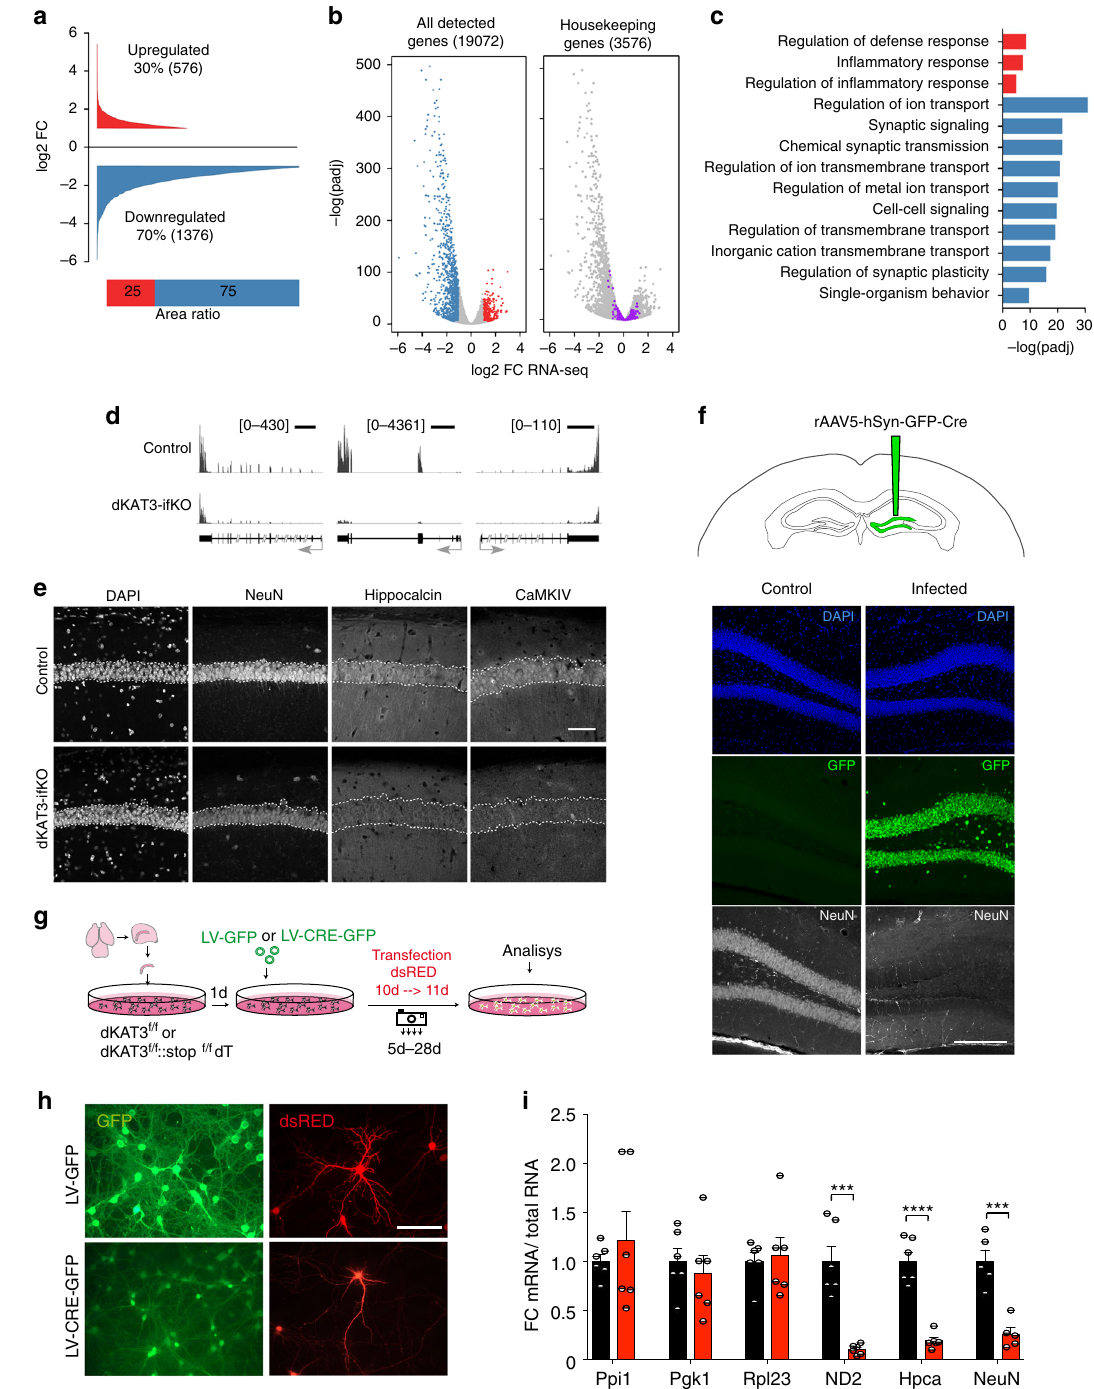
CBP and p300 bind to the same regulatory regions . The evi- dence above indicates that KAT3 proteins play a redundant role in preserving neuronal identity. To explore the basis of such redundancy, we next mapped the occupancy of hippocampal chromatin by CBP and p300. Chromatin immunoprecipitation followed by whole-genome sequencing (ChIP-seq) using anti- bodies that differentiate between the two paralogous proteins (Supplementary Figs. 1b and 9a) retrieved 37,359 peaks in the chromatin of wild type mice (Fig. 4a, Supplementary Fig. 9b, and Supplementary Data 3). Considering the different ef fi ciencies of the two antibodies, we detected an almost complete